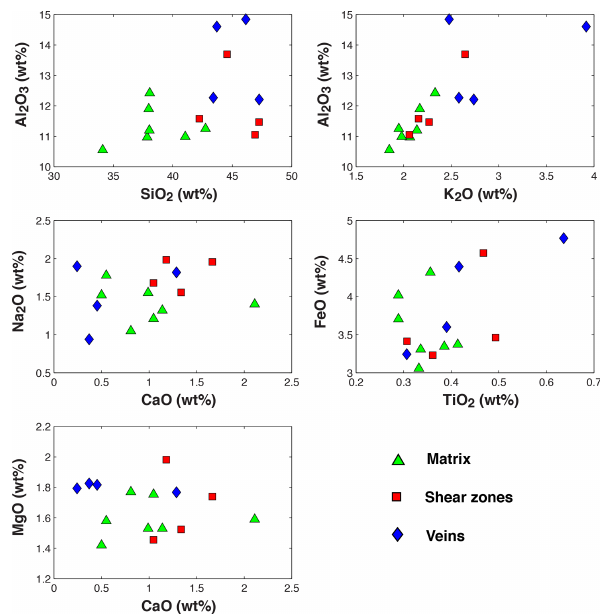
Figure 9. Averaged major-element concentrations of EPMA anal- yses in the clay-size fraction of shear zones, of veins, and of their host sediment matrix. Data provided in Table